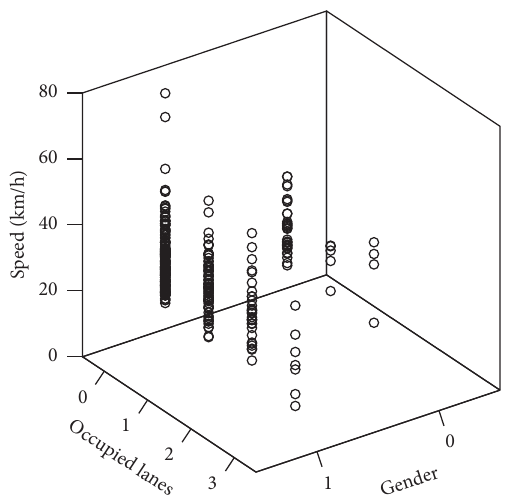
Figure 6: Relationship between traveling speed and illegal lane occupation behavior.